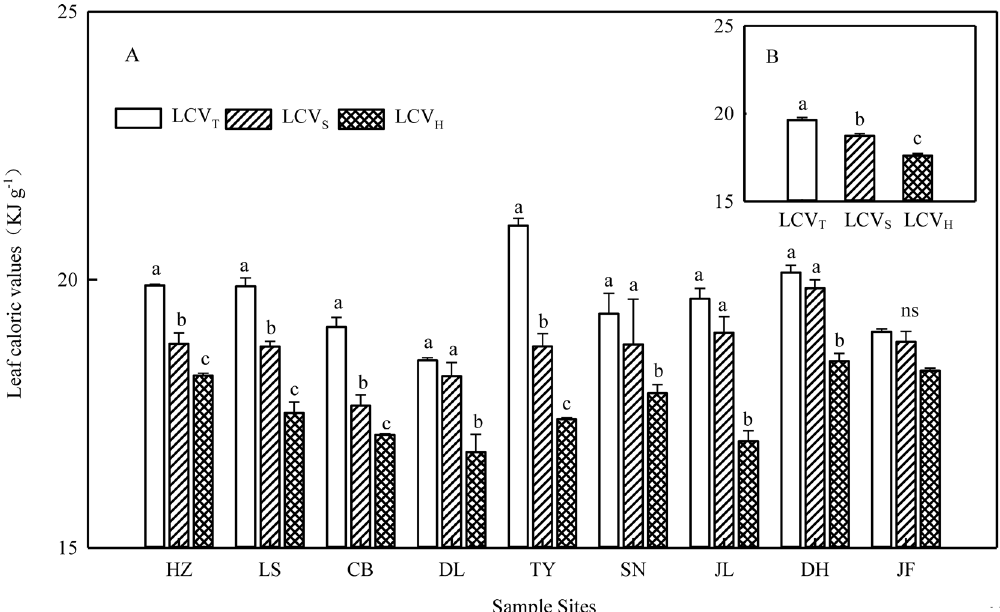
Fig 2. Changes in leaf caloric value among different plant functional groups. LCV T , LCVs, and LCV H , are the average of leaf caloric values weighted for the relative leaf biomass of trees, shrubs, and herbs, respectively. HZ, Huzhong; LS, Liangshui; CB, Changbai; DL, Dongling; TY, Taiyue; SN, Shennongjia; JL, Jiulian; DH, Dinghu; JF, Jianfengling. Panel A and B were calculated at each site and for the total transect, respectively. Data are represented as mean ± S.E. Different letters indicate a significant difference among plant functional types ( p < 0.05).